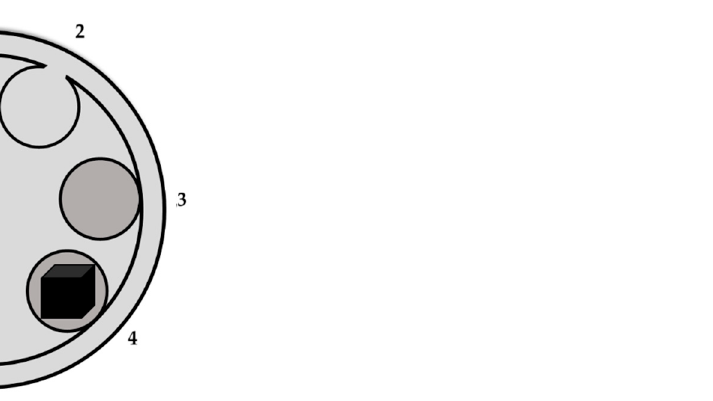
Figure 2. Schematic representation of magnetosome biomineralization: (1) invagination of the cytoplasmic membrane, (2) membrane growth, protein incorporation, and iron accumulation in external space, (3) other proteins incorporation, the release of the vesicle from the cytoplasmatic membrane, inner environment modification, (4) iron uptake into vesicle and magnetite nucleation initiation, (5) crystal and membrane growth, (6) crystal and membrane growth, magnetosome alignment into chains.